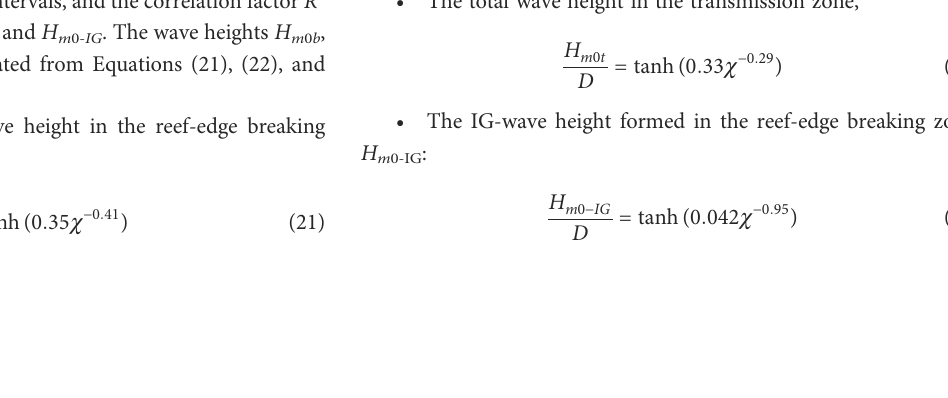
TABLE 3 Empirical coef fi cients a and b in Equation (20) and the correlation factor R 2 .